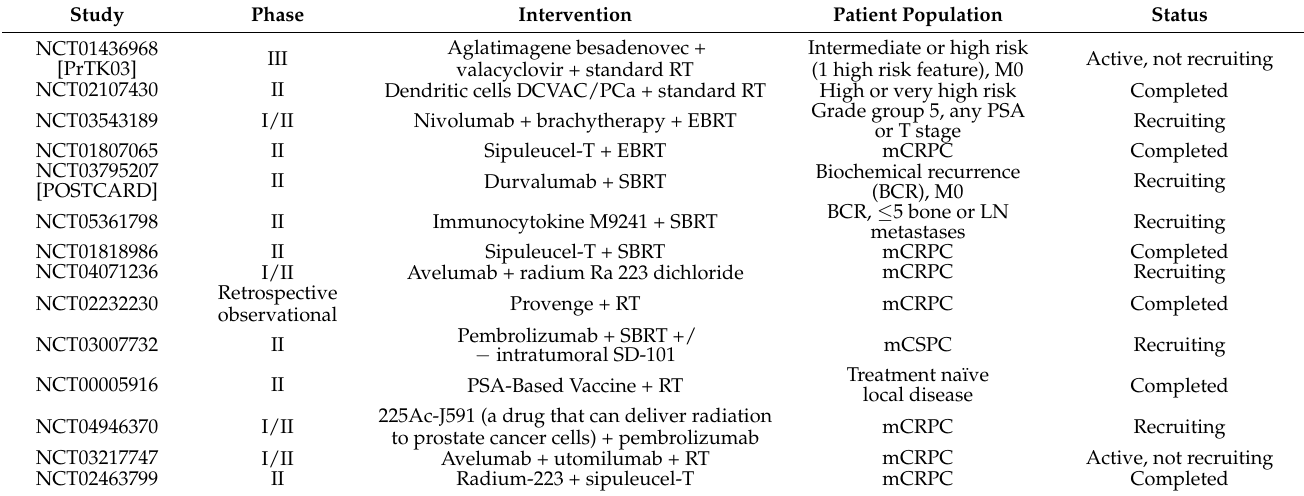
Table 2. Clinical Trials of Immunotherapy and Radiotherapy in Prostate